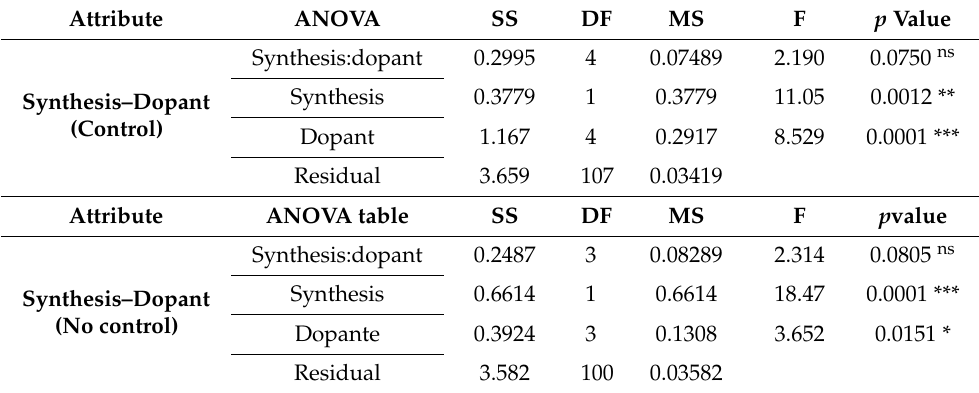
Table 7. Two-way ANOVA test for the total gallic acid content in